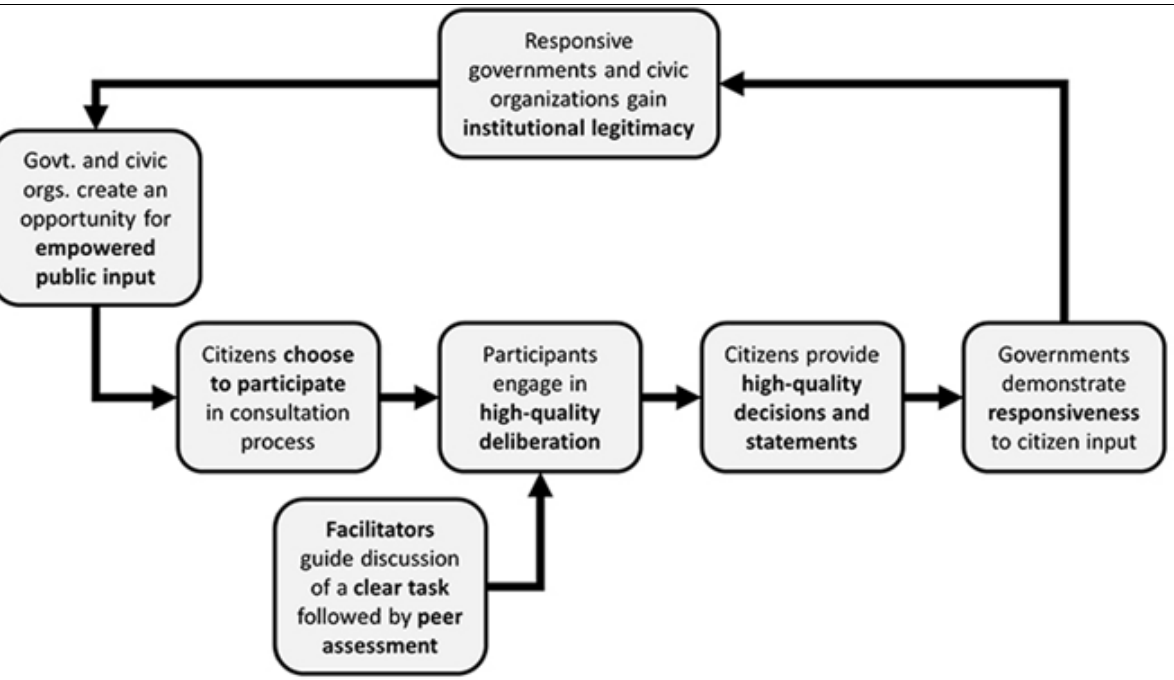
Figure 1: A feedback-loop model of deliberative legitimacy showing a chain of hypothesized causal paths in a public consultation